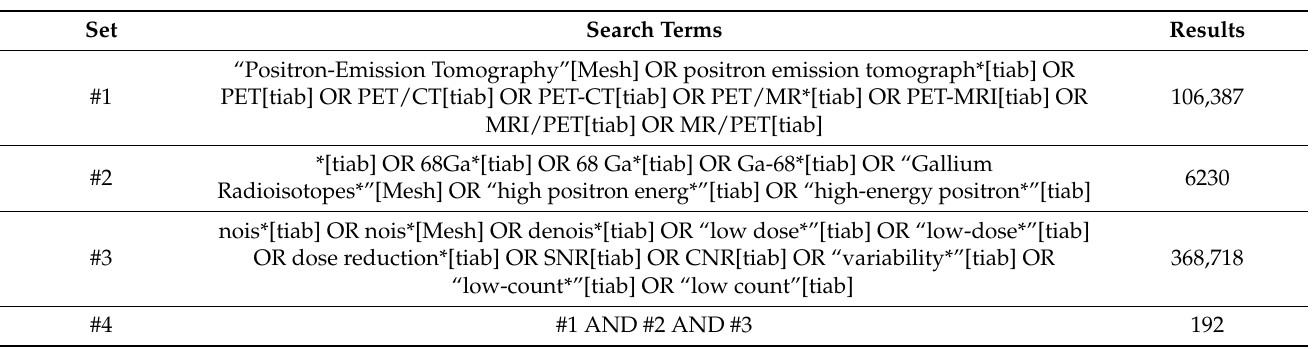
Table A3. The search query for noise reduction techniques in PubMed. In the column “Results”, the numbers of records are provided for the corresponding search terms from between January 2010 until 1 August